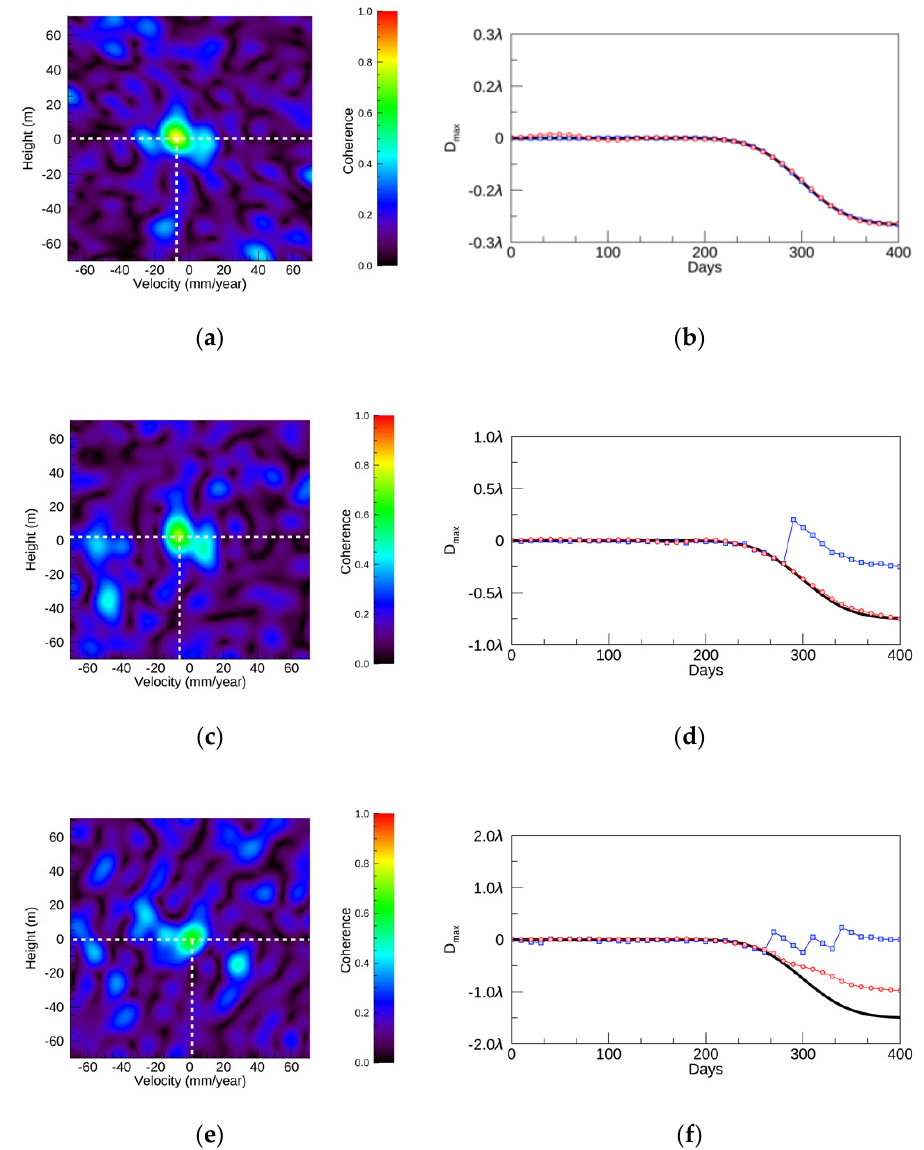
Figure 6. ( a ) The scattering distribution map (SDM) with a D max value of 0.25 𝜆 and a CDF variance of 15. The horizontal dashed white line shows the selected height, and the vertical dashed white line shows the selected velocity in the ConvPSI. ( b ) The resulting displacement of ( a ). ( c ) The SDM with a D max value of 0.75 𝜆 and a CDF variance of 15. ( d ) The resulting displacement of ( c ). ( e ) The SDM with a D max value of 1.5 𝜆 and a CDF variance of 15. ( f ) The resulting displacement of ( e ). In the time plots, the red, blue, and black lines show the NN-PSI, ConvPSI, and modeled displacements, respectively.